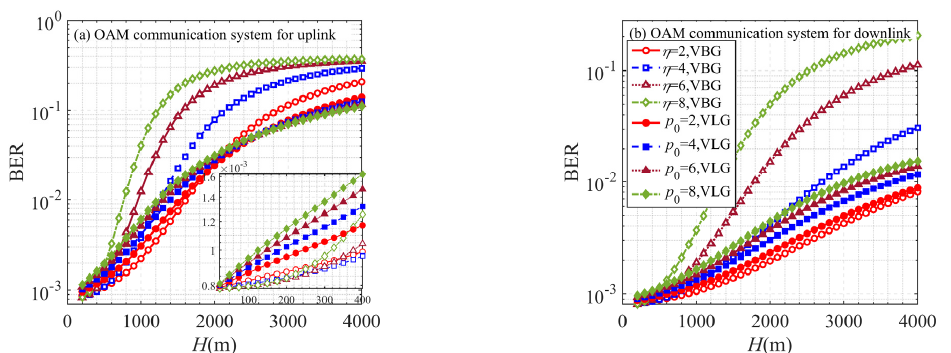
Figure 11. Average BER of air–ground OAM communication systems versus H with different η or p 0 for uplink ( a ) and downlink ( b ).